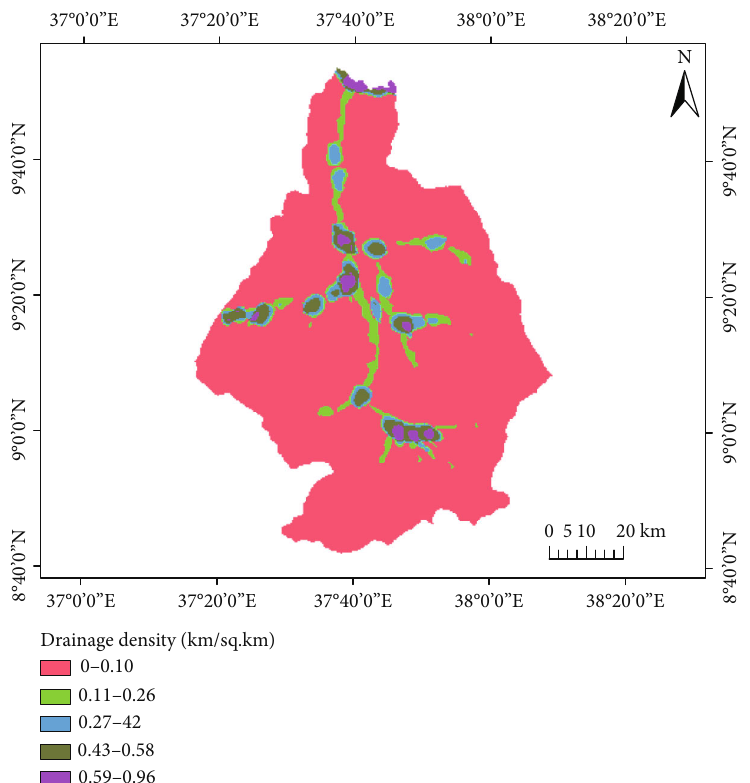
Figure 3: Drainage density of Guder